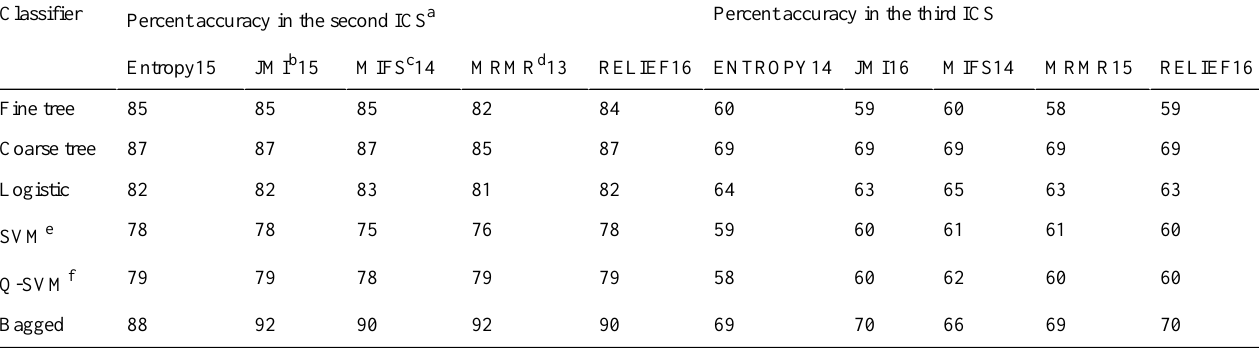
Table 2. Accuracy of the feature engineering classifiers using machine